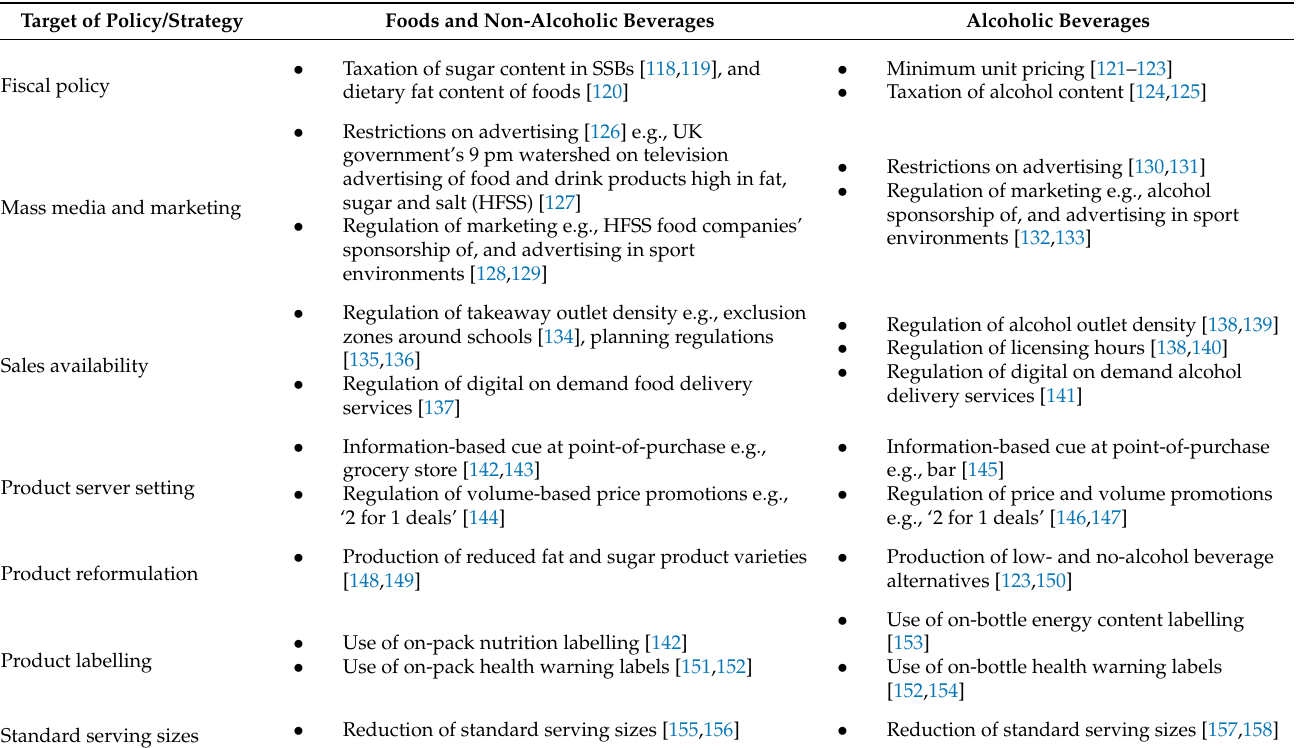
Table 1. Population-level food and alcohol policies across shared targets/points of intervention. Target of